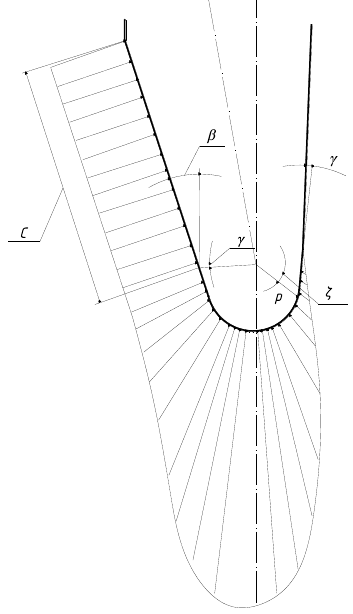
Fig. 1. Scheme of stress distribution in the cutting part of the ploughshare